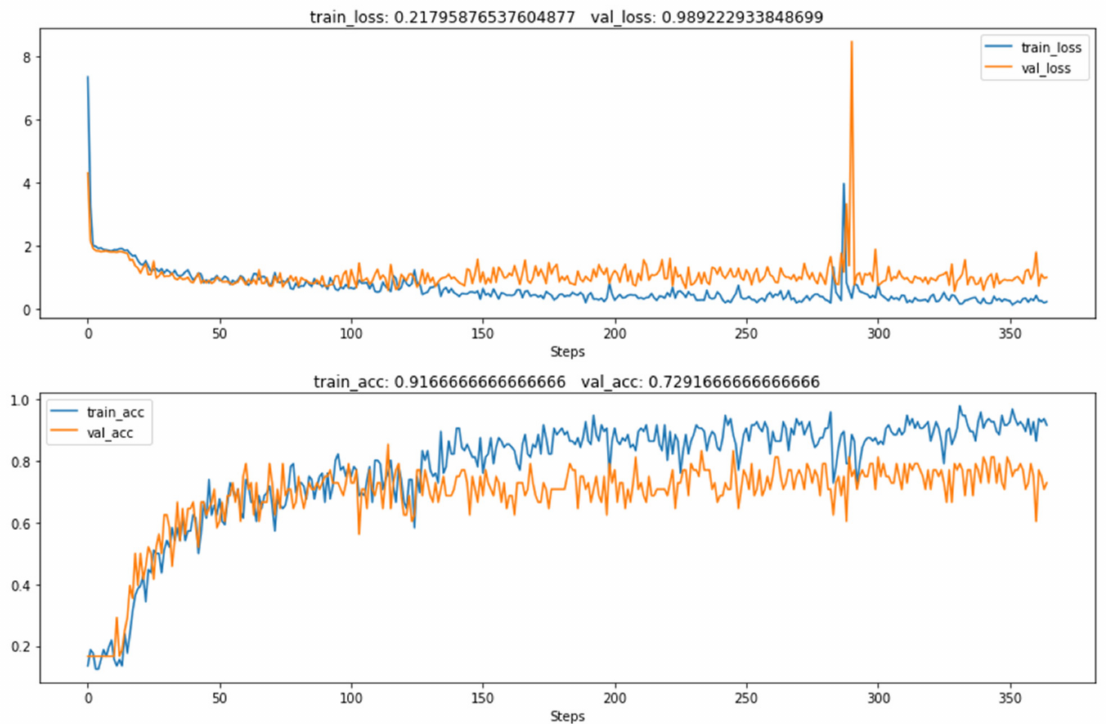
Figure 9. Vgg16 network training process under small